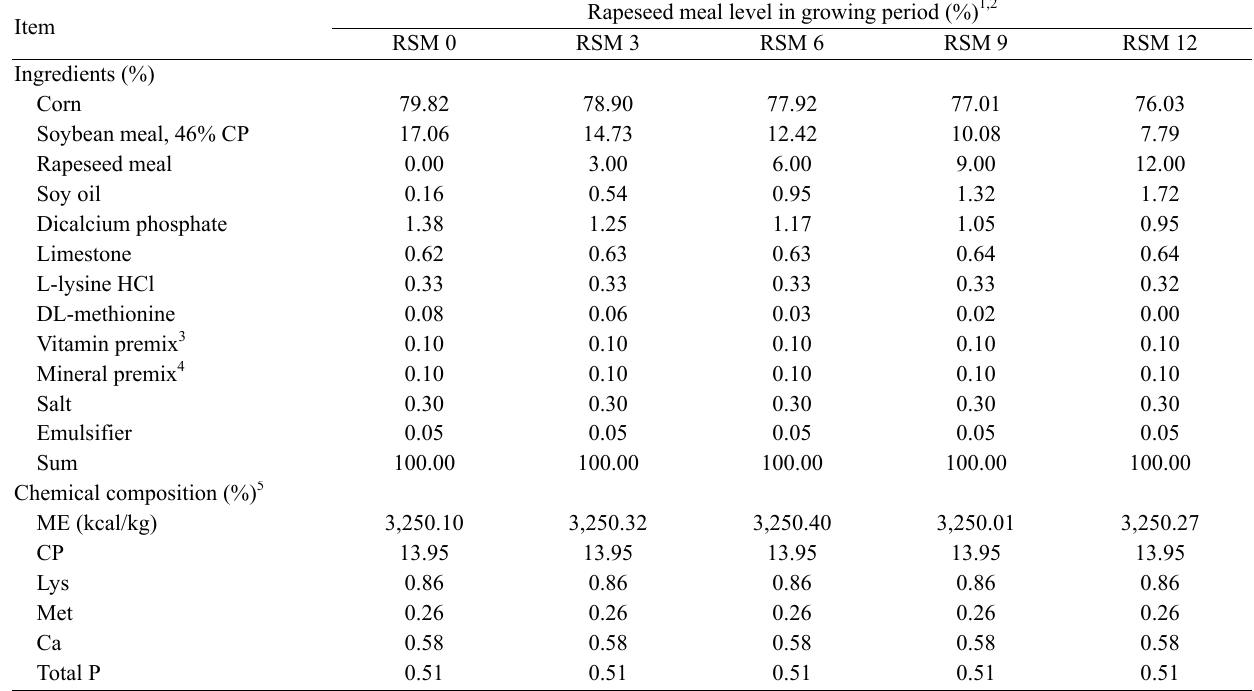
Table 2. The formula and chemical composition of experimental diets in growing period (as-fed basis)